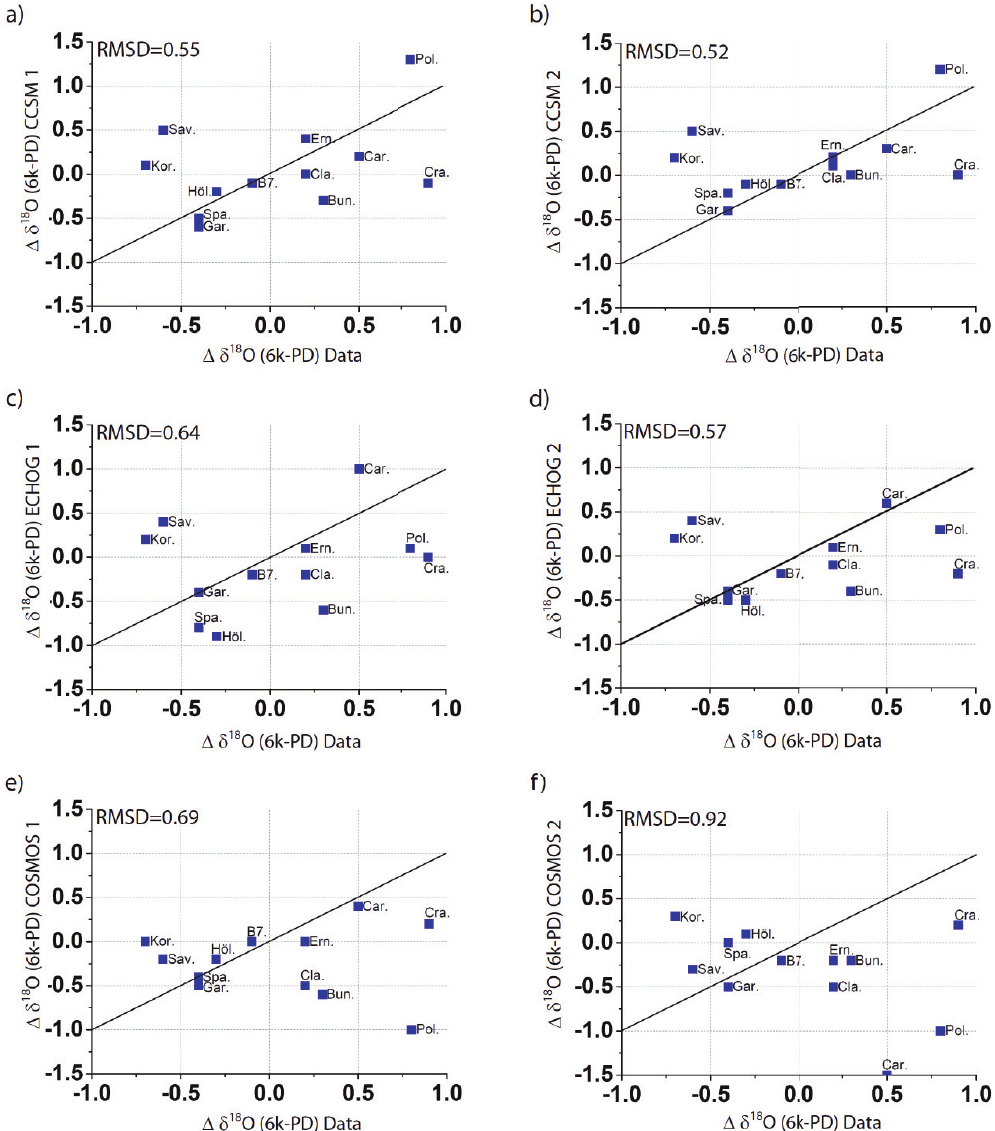
Fig. 6. Modelled versus measured stalagmite δ 18 O calcite (6k-PD) values for the different model setups. The value of the Root Mean Square Deviation, RMSD, gives an evaluation of how well the modelled δ 18 O calcite (6k-PD) values agree with the data. Black lines indicate the 1:1 ratio. All calcite δ 18 O values refer to